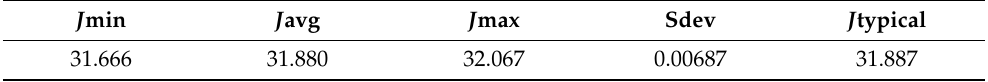
Table 3. Results of the simulation series for RHC_EA with control input range estimation Run No.